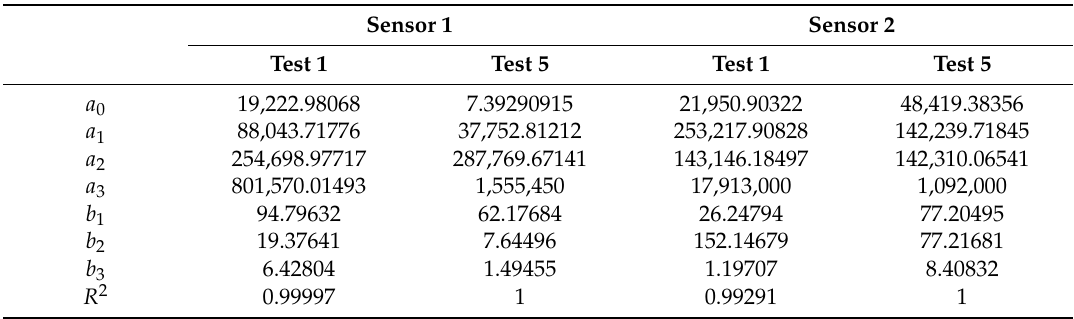
Table 1. The fitting parameters of the Equation (1) corresponding to the experimental data for Sensor 1 and Sensor 2, respectively.